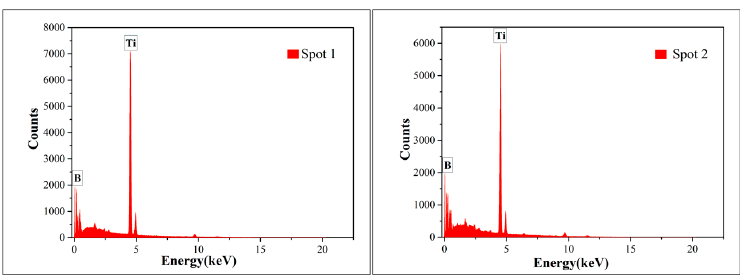
Figure 3. SEM (scanning electron microscopy) images and EDS (energy dispersive spectroscopy) results of the surface and cross section of the TiB 2 film formed under the condition of a TiCl 4 /BCl 3 gas flow ratio of 0.5.